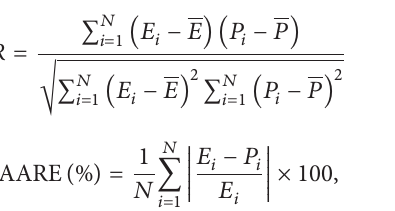
with two neurons in the hidden layer and further carried out with more neurons. Figure 5 shows the influence of number of neurons in the hidden layer on the network